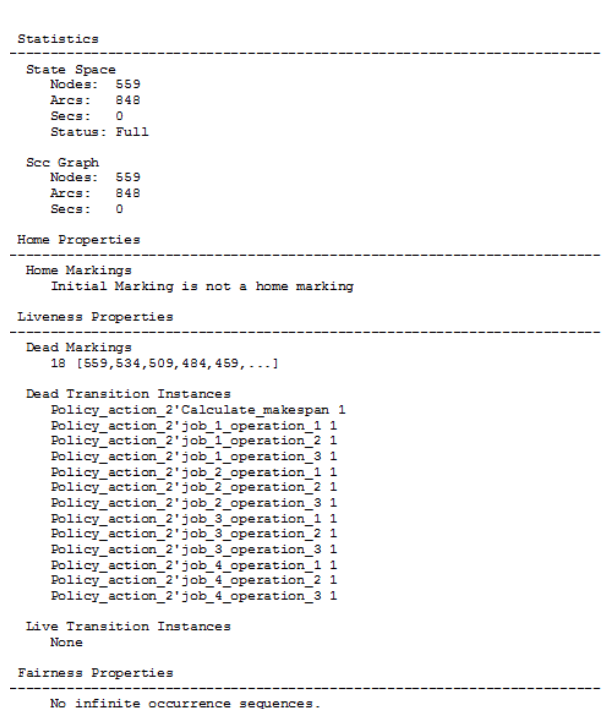
Figure 7. State space results for the CTPN scheduling system model of the job shop example introduced in [26] with lot size (1,1,1,1), implemented with one scheduling cycle.